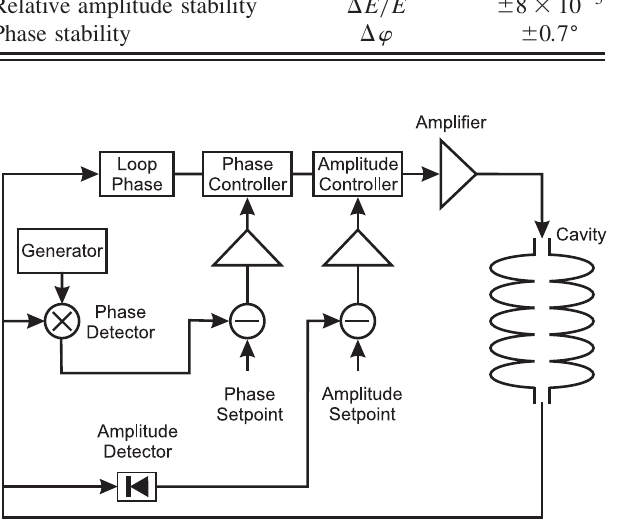
FIG. 2. Self-excited